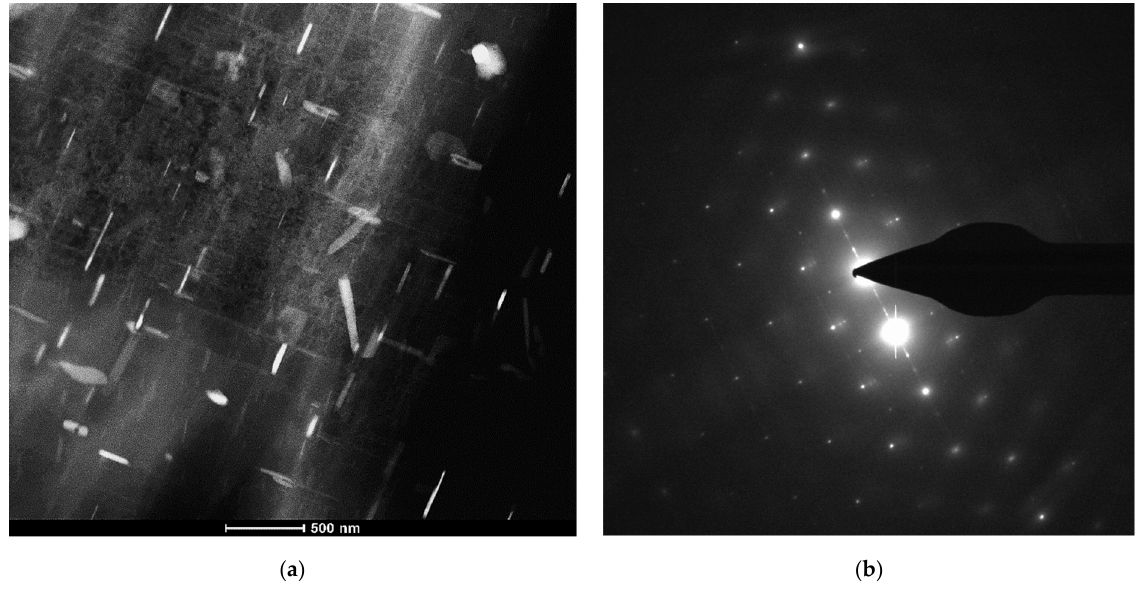
Figure 14. ( a ) High-angle annular dark-field image of alloy M1S in T6-treated condition (no stabilization treatment), and ( b ) the selected area electron diffraction (SAED) pattern.